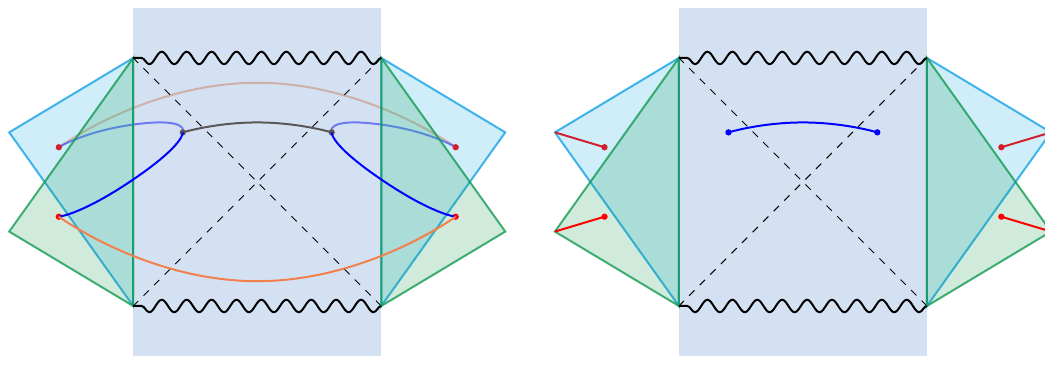
Figure 11: The information paradox for the thermofield double state. Left : the com- putation of the entanglement entropy of the radiation region using RT surfaces. The orange lines are the RT saddles that dominate at early times, in which the entropy increases linearly in time. The blue lines are the RT saddles that cross the brane, and are constant in time, thus saturate the entanglement entropy. The gray line is the island. Right : the same computation in the two dimensional perspective using the generalized entropy formula. The blue dots represent the QES, and the blue line is the